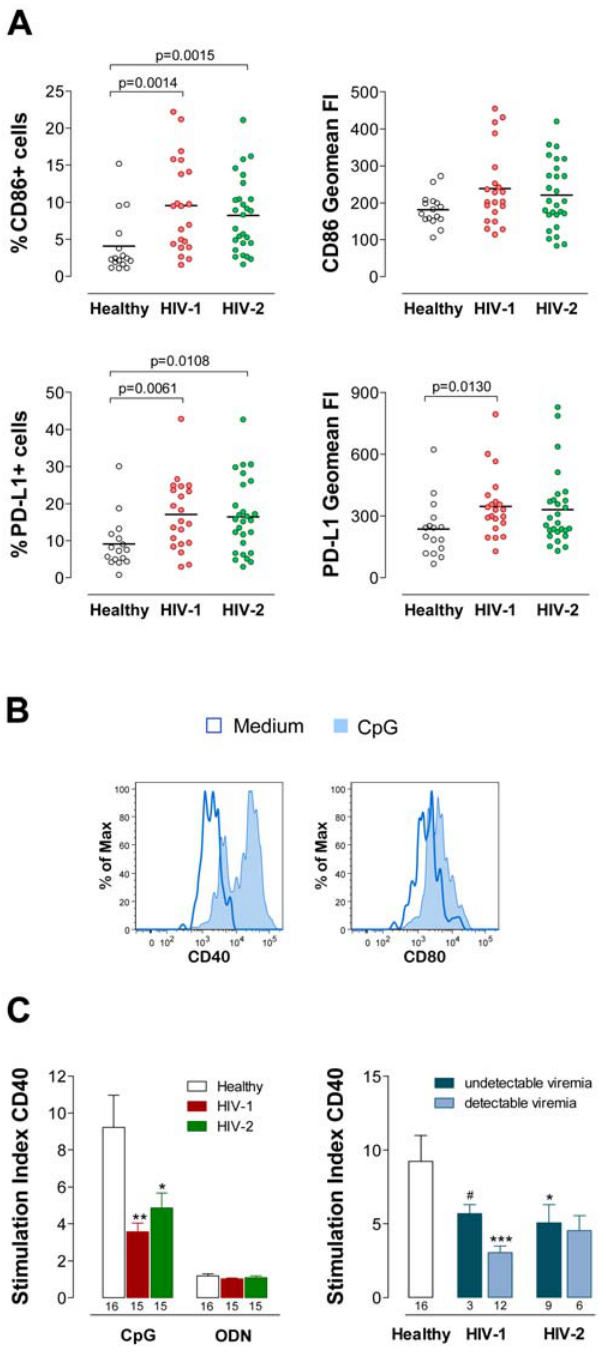
Figure 3. pDC Phenotype. ( A ) Phenotype of circulating pDC in HIV-1 and HIV-2 infections. Levels of expression of CD86 and PD-L1 on pDC from freshly isolated PBMC assessed as proportion within pDC and as geomean FI within total pDC measured by flow cytometry. Each dot represents one individual and bars represent mean. ( B ) pDC phenotype upon CpG stimulation. Freshly isolated PBMC were cultured with medium alone, CpG or the non-CpG ODN control. pDC phenotype was assessed by flow cytometry after 22 hours. Histograms represent the analysis of CD40 and CD80 expression upon CpG stimulation within pDC in a representative HIV-2 infected patient with 508 CD4 T cells/ m l and 13627 HIV-2 RNA copies/ml. After a large gate including lymphocytes and monocytes defined by forward and side scatter, cells were sequentially gated on HLA-DR + cells that do not express